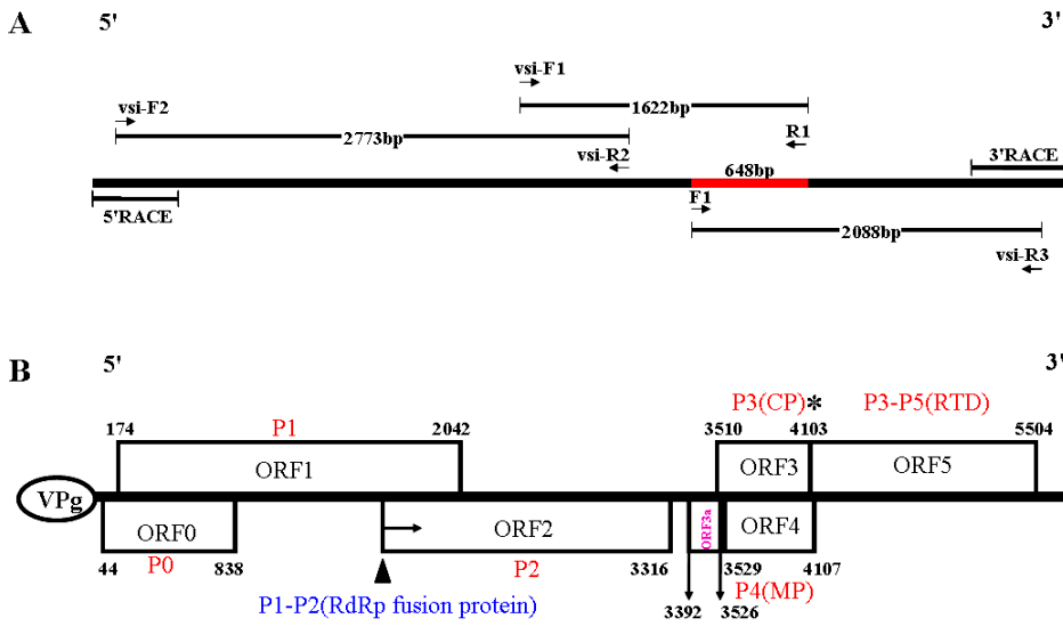
Figure 2. ( A ) Schematic diagram of MaYMV cDNA cloning strategy. The relative positions of primers and RT-PCR products are shown as arrows and line segments, respectively. Vsi designation corresponds to primers that were designed based on virus-derived siRNA sequences. The red line represents the size and position for initially validation of MaYMV by using primer pairs F1/R1; and ( B ) a schematic representation of the genome organization of MaYMV. The predicted frameshift heptanucleotide is marked with a filled triangle, and the “leaky” amber stop codon with an asterisk. RdRp, RNA-dependent RNA polymerase; CP, coat protein; MP, movement protein; RTD, readthrough domain.